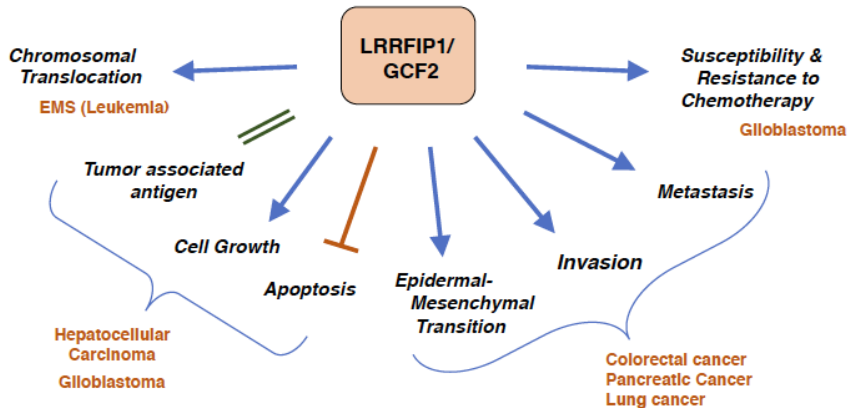
Figure 4. Cancers and LRRFIP1/GCF2. Overexpression of LRRFIP1/GCF2 plays a role in the development of cancer and malignant phenotypes, and the inhibitions of the expression reverse the malignant phenotypes. Chromosomal Translocation ; an in-fusion transcript of LRRFIP1/GCF2 and FGFR1 gives rise to a leukemia with 8p11 myeloproliferative syndrome (EMS) [70]. Tumor associated antigen , Cell Growth and Escape from Apoptosis ; LRRFIP1/GCF2 is a tumor associated antigen as it is highly expressed in hepatocellular carcinoma (HCC), and knockdown of LRRFIP1/GCF2 causes growth inhibition of HCC and glioblastoma cell lines and apoptosis of HCC cell lines [72,74]. Epidermal Mesenchymal Transition, Invasion and Metastasis ; LRRFIP1/GCF2 promotes epithelial mesenchymal transition (EMT) in colorectal, pancreatic, and lung cancers, and silencing of LRRFIP1/GCF2 reverses EMT and inhibits migration and invasion of the cancers [15,73]. Susceptibility and Resistance to Chemotherapy ; Resistance of a glioblastoma cell line to teniposide, a topoisomerase II inhibitor, is mediated by the down regulation of LRRFIP1/GCF2 expression. Up-regulation of LRRFIP1/GCF2 makes the glioblastoma cell line sensitive to VM-26, and glioblastoma patients with higher LRRFIP1/GCF2 expression have better prognosis with teniposide treatment [75]. The epidermoid carcinoma cell lines with over-expressed LRRFIP1/GCF2 were reported to be sensitive to doxorubicin and vincristine, but resistant to cisplatin, and cisplatin-resistant cell lines expressed higher level of LRRFIP1/GCF2